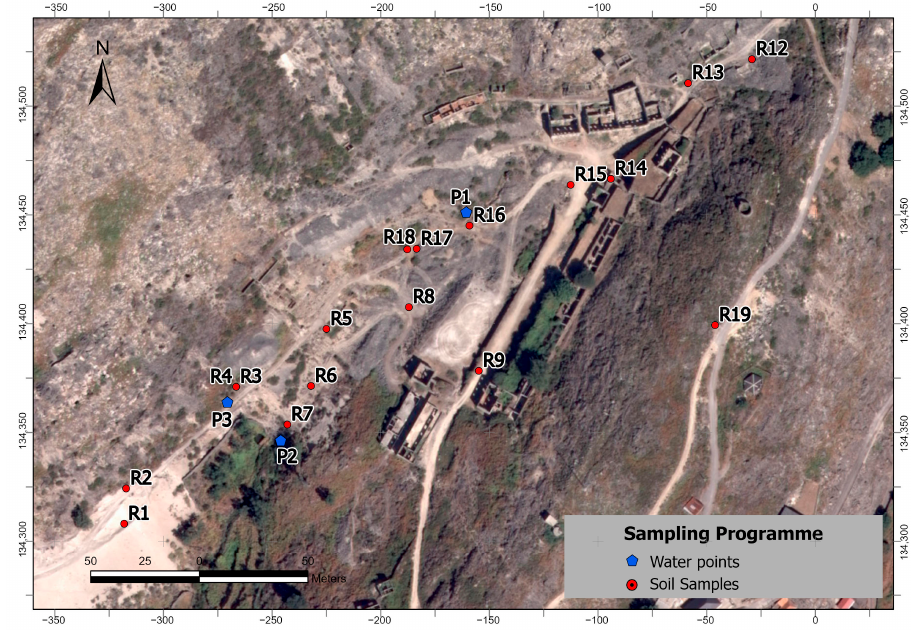
Figure 6. Sampling sites in soils and mining waste tails and water sample locations.